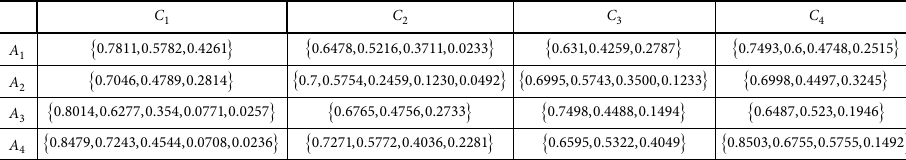
Table 6. Collective hesitant fuzzy decision